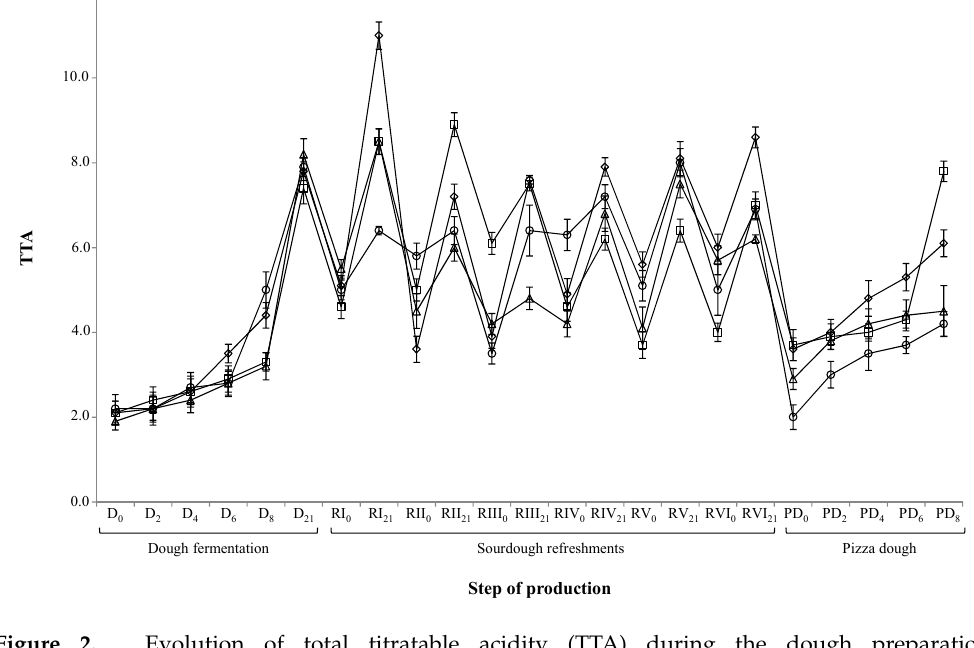
Figure 2. Evolution of total titratable acidity (TTA) during the dough preparation, sourdough propagation, and pizza dough production. Symbols: rhombus—CTR-semolina; triangle—OHS-semolina; circle—FHS-semolina; square—OFHS-semolina. Table 1. Organic acids produced during pizza dough fermentation.